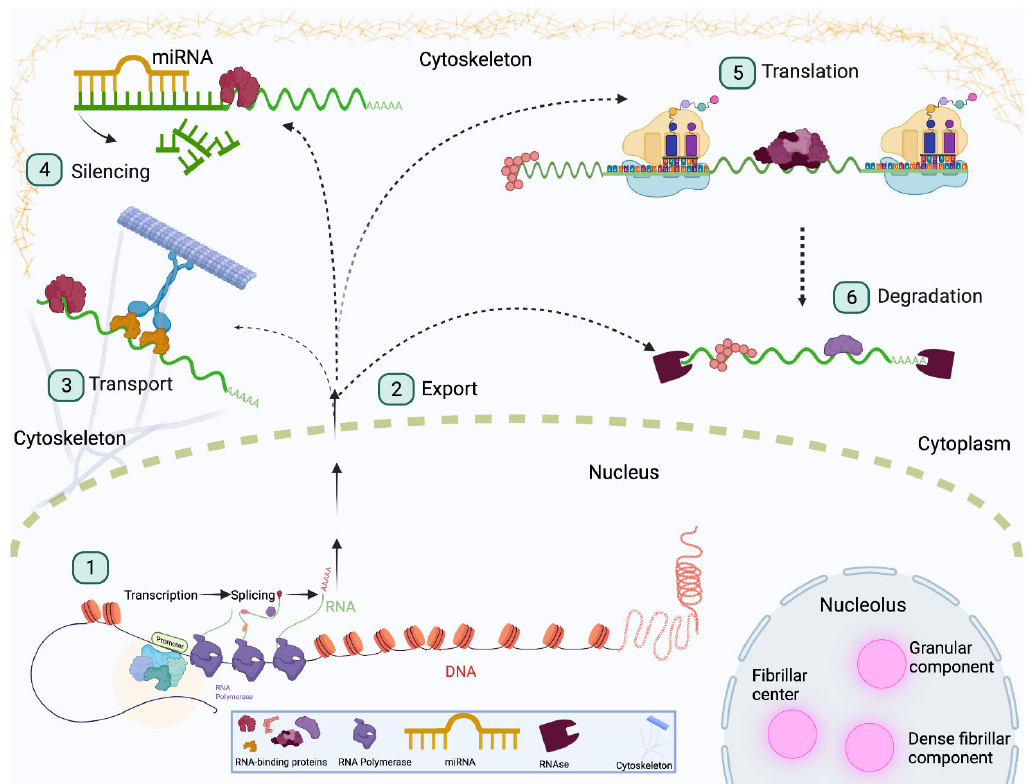
Figure 1. RNA-binding proteins regulate RNA fate. RBPs are involved in all stages of RNA processing including transcription, translation, splicing, transport, degradation, and silencing. These processes are depicted in the above diagram. RNA targets are bound by RBPs prior to leaving the nucleus and remain associated with RBPs until they are degraded. (1) RBPs such as Rbfox1 and Qki serve as alternative splicing factors to ensure cells have the correct genetic profile. (2) Shuttling of RNA between the nucleus and cytoplasm is also mediated by RBPs, as observed with CELF2. (3) RNA can also be transported to subcellular locations, and this is often conducted through a complex consisting of molecular motors and RBPs, as observed with ZBP1. (4) RBPs also interact with silencing factors such as miRNA to degrade certain targets. The RBP Pumilio facilitates miRNA binding by exposing binding sites that would otherwise be inaccessible. (5) RBPs also promote post-transcriptional processes. For example, Imp binds targets to stabilize mRNA and promote translation. (6) Some RBPs, such as Stau1, promote degradation of certain RNA targets to promote stem cell Table 1. Conserved RNA ‐ binding proteins. Table showing RBPs conserved in Drosophila melano ‐ gaster (Dmel), humans (Hs), Caenorhabditis elegans (Ce), and Dario rerio (ZF). Resident tissue, func ‐ tion, binding domains, and associated references for each RBP are also listed. Tissue/Function Binding Domain Ref. regulates stability, translation, transport of targets, axonal transport